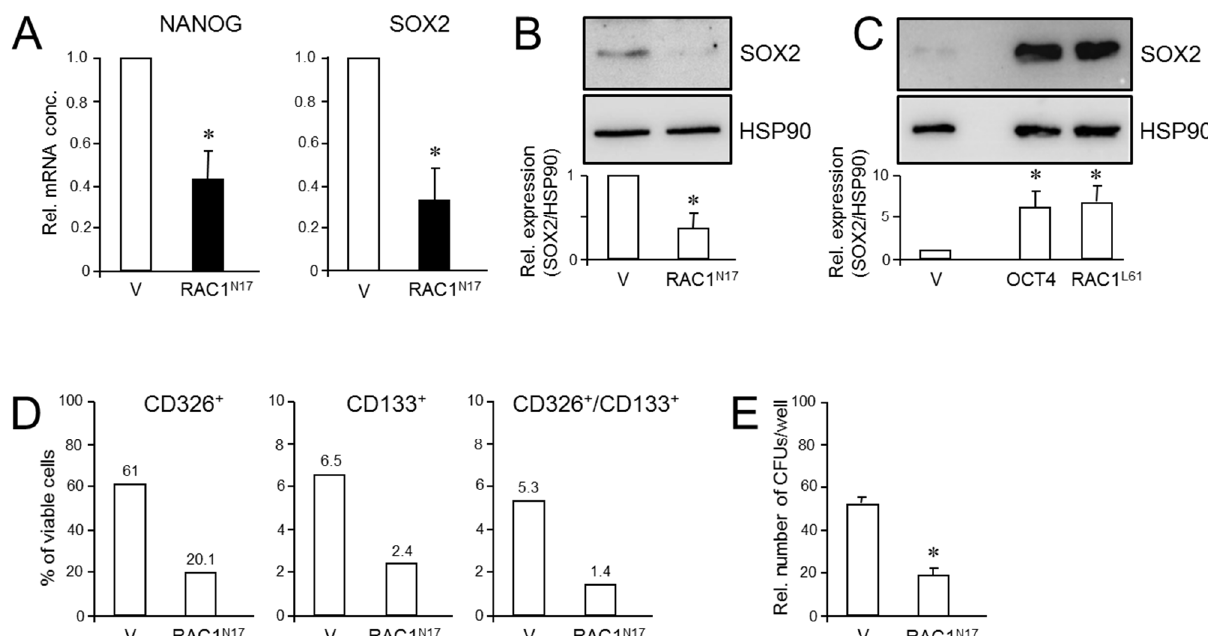
Figure 4. Effect of dn interference with RAC1 activation on stem cell marker expression and clonogenicity in PANC-1 cells. ( A ) PANC-1 RAC1-N17 cells and empty vector controls (V) were assayed by qPCR for NANOG and SOX2 mRNA abundance. Data are the mean ± SD of three experiments. ( B ) As in ( A ) except that cells were analyzed by immunoblotting for SOX2. The graph underneath the blots depicts results from densitometry-based quantification of band intensities (mean ± SD, n = 3). ( C ) SOX2 immunoblotting of PANC-1 cells transfected with an expression for RAC1 L61 . As positive control, cells were transfected with an expression vector for OCT4, which is known to transcriptionally induce SOX2 expression [41]. ( D ) PANC-1 RAC1-N17 cells were labeled singly or in combination with antibodies to CD326 or CD133, and measured by flow cytometry. Data shown are representative of three experiments. ( E ) PANC-1 RAC1-N17 and V cells were seeded at a density of 40 cells/cm 2 and incubated in standard growth medium for 10 d. Colonies formed were fixed with paraformaldehyde, stained with crystal violet, and CFUs >50 cells counted manually. Data shown are representative of three experiments (mean ± SD of triplicate wells). Asterisks ( ∗ ) indicate a significant difference relative to controls ( p < 0.05, Student’s t -test).